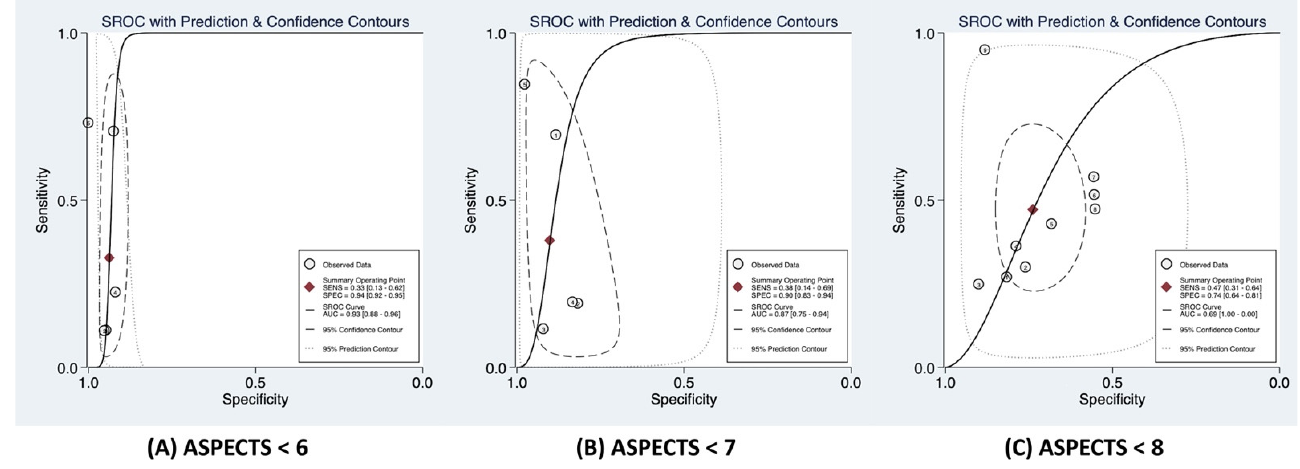
Figure 4. The summary receiver operating characteristics curves for the association of ( A ) ASPECTS < 6, ( B ) ASPECTS < 7 and ( C ) ASPECTS < 8 with functional outcomes at 90 days (mRS 90 days) in acute ischaemic stroke patients considered for, or receiving, reperfusion therapy. Note: the summary receiver operating characteristics curves for the association of continuous ASPECTS with functional outcomes at 90 days (mRS 90 days) in acute ischemic stroke patients receiving reperfusion therapy cannot be generated. Abbreviations: ASPECTS: Alberta Stroke Programme Early CT Score; mRS: modified Rankin Score.